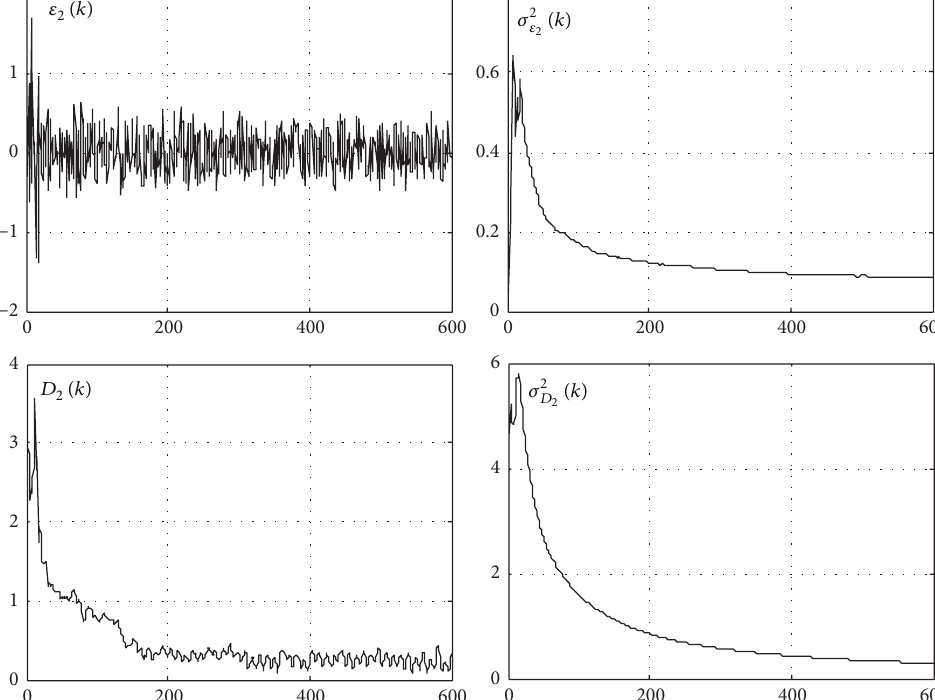
Figure 5: Evolution curves of the prediction error 𝜀 2 (𝑘) , the parametric distance 𝐷 2 (𝑘) , and their overall variances 𝜎 2 𝜀